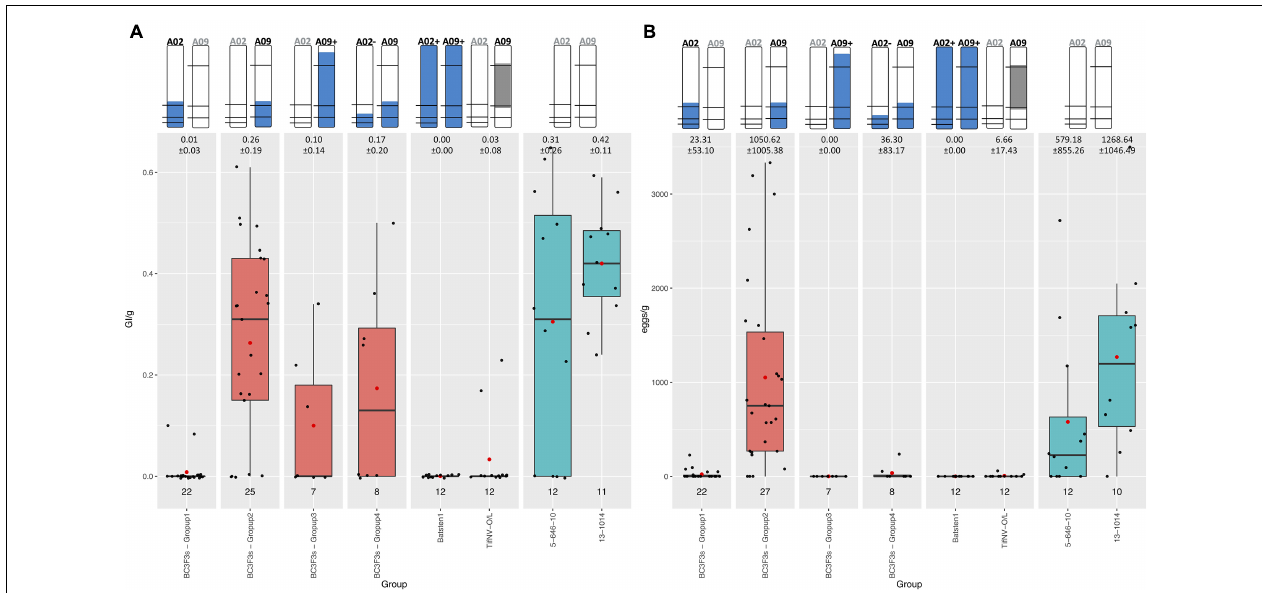
FIGURE 4 | Boxplot diagrams for Galling index per gram of root (GI/g) (A) and Number of eggs per gram of root (eggs/g) (B) of BC 3 F 3 lines, resistant controls Batsten1 and A. hypogea TifNV-High O/L, and susceptible controls 5-646-10 and 13-1014. BC 3 F 3 lines were grouped according to the A. stenosperma alleles that they are carrying as: • Group 1: bottom A02 (A02) ( A. stenosperma allele at A02-83,464,195, A02-92,077,207, and A02-92,983,792); • Group 2: bottom A09 (A09) ( A. stenosperma allele at A09-112,309,231 and A09-114,515,959); • Group 3: large A09 (A09+) ( A. stenosperma allele at A09-16,516,448, A09-112,309,231 and A09-114,515,959); and • Group 4: Both bottom small A02 ( A. stenosperma allele at A02-92,077,207 and A02-92,983,792) and bottom A09 (A02- and A09). The top of the figure indicates the introgression in A02 and A09 from A. stenosperma in blue and SNP markers as black horizontal lines. For TifNV-High O/L, resistance from A. cardenasii is colored in gray. The numbers at the top of the bars indicate the mean ± SD . The numbers above the groups indicate the number of lines included in each group. Complete pedigree in Supplementary Table 8 . Black bars across boxes indicate the median and red dot the mean. BC 3 F 3 s in salmon color and controls in teal